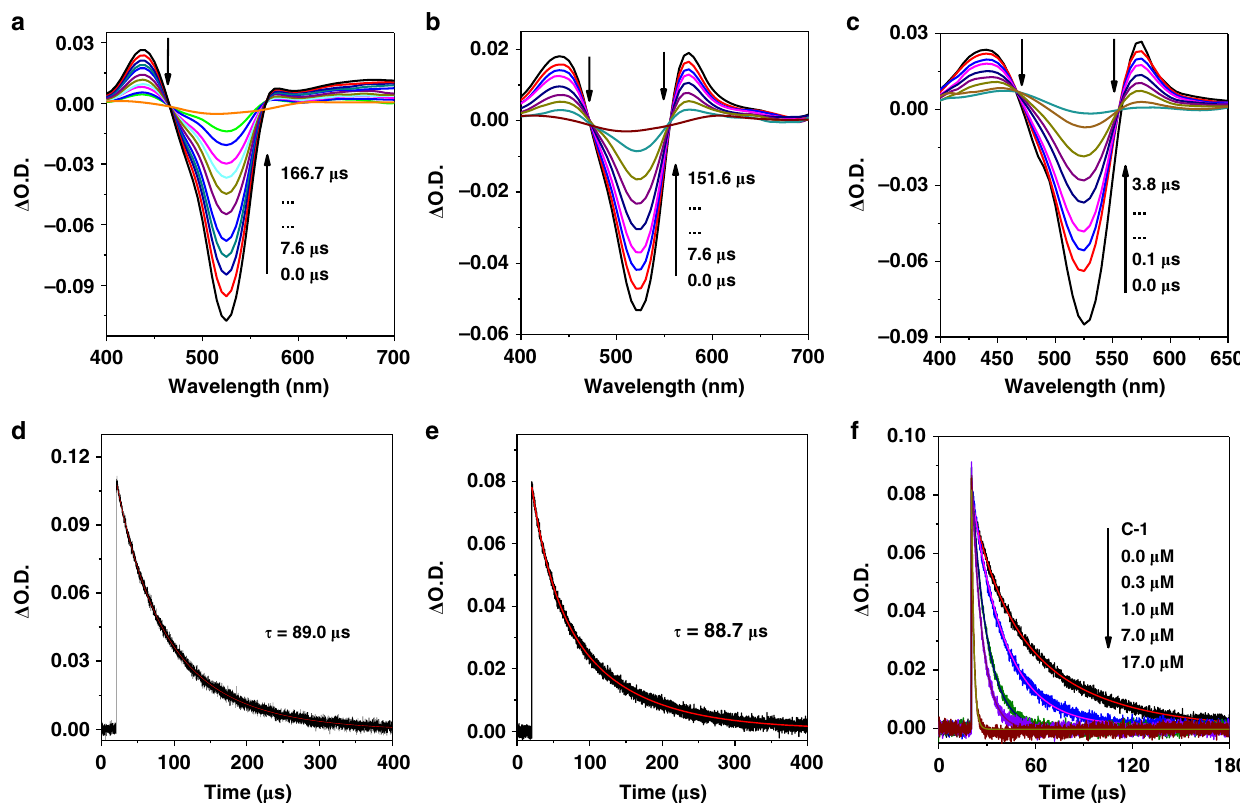
Fig. 6 Nanosecond transient absorption spectra of Ir-4. a Ir-4 , b Ir-4 in the presence of 40 mM of DMT , c reduced Ir-4 in the presence of 0.2 mM of C-1 , d the decay of Ir-4 at 517 nm, e kinetic traces of the reduced Ir-4 followed at 525 nm, f kinetic traces of reduced Ir-4 with different concentration of C-1 followed at 525 nm. These spectra were recorded in CH 3 CN after pulsed excitation at 532 nm under N 2